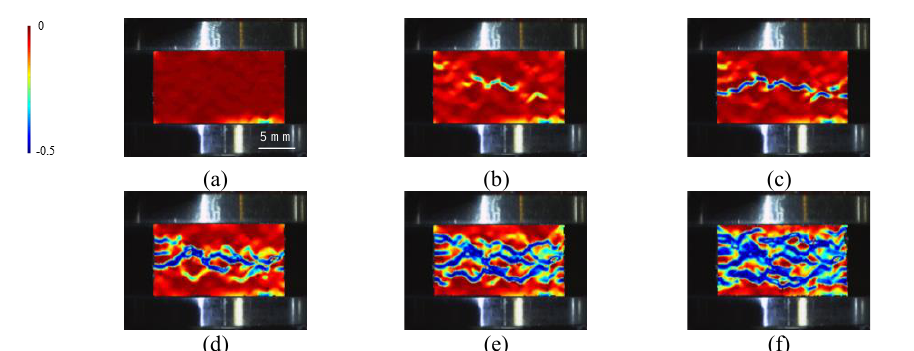
Fig. 7. Strain distribution in dynamic test in the case of expansion ratio of 12; at engineering strain of (a) 0.04, (b) 0.08, (c) 0.12, (d) 0.19, (e) 0.32, (f) 0.44.